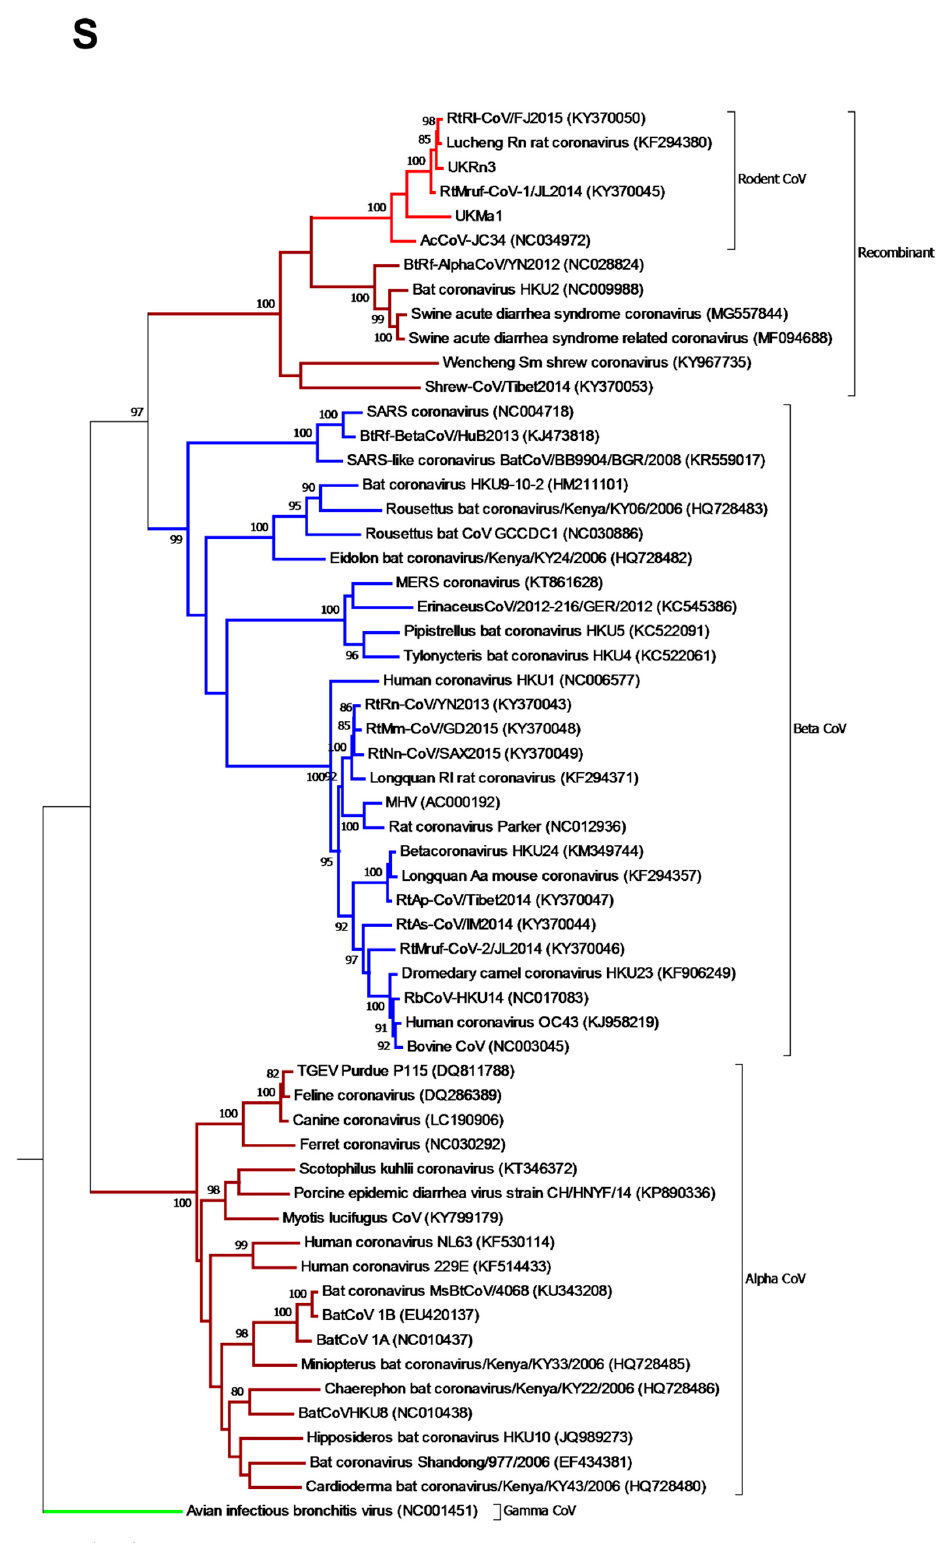
Figure 4. Phylogenetic relationships of the rodent alphacoronaviruses based on the S gene. Maximum likelihood phylogenetic analysis of coronavirus partial S gene sequences corresponding to positions 1831–3228 of the Lucheng Rn CoV (KF294380), indicating that the rodent alpha-CoVs formed a distinct clade within the genus Betacoronavirus . The novel coronavirus sequence obtained from a